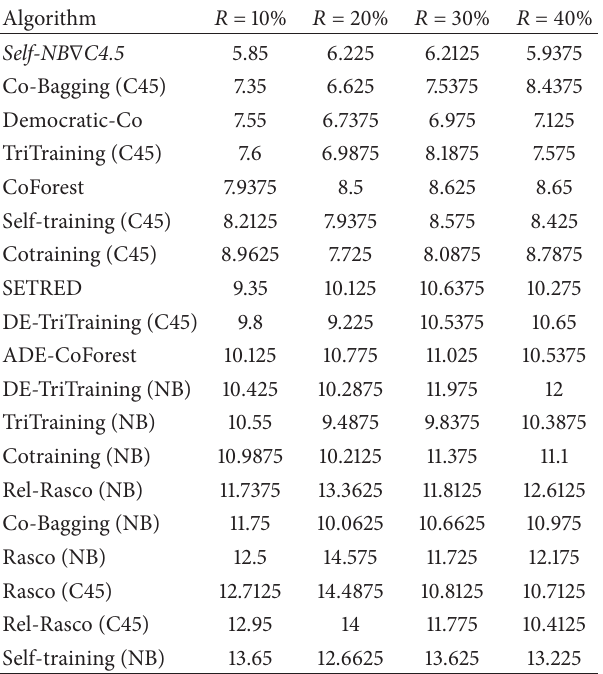
Table 5: Friedman ranking of the algorithms in all tested labeled ratios.